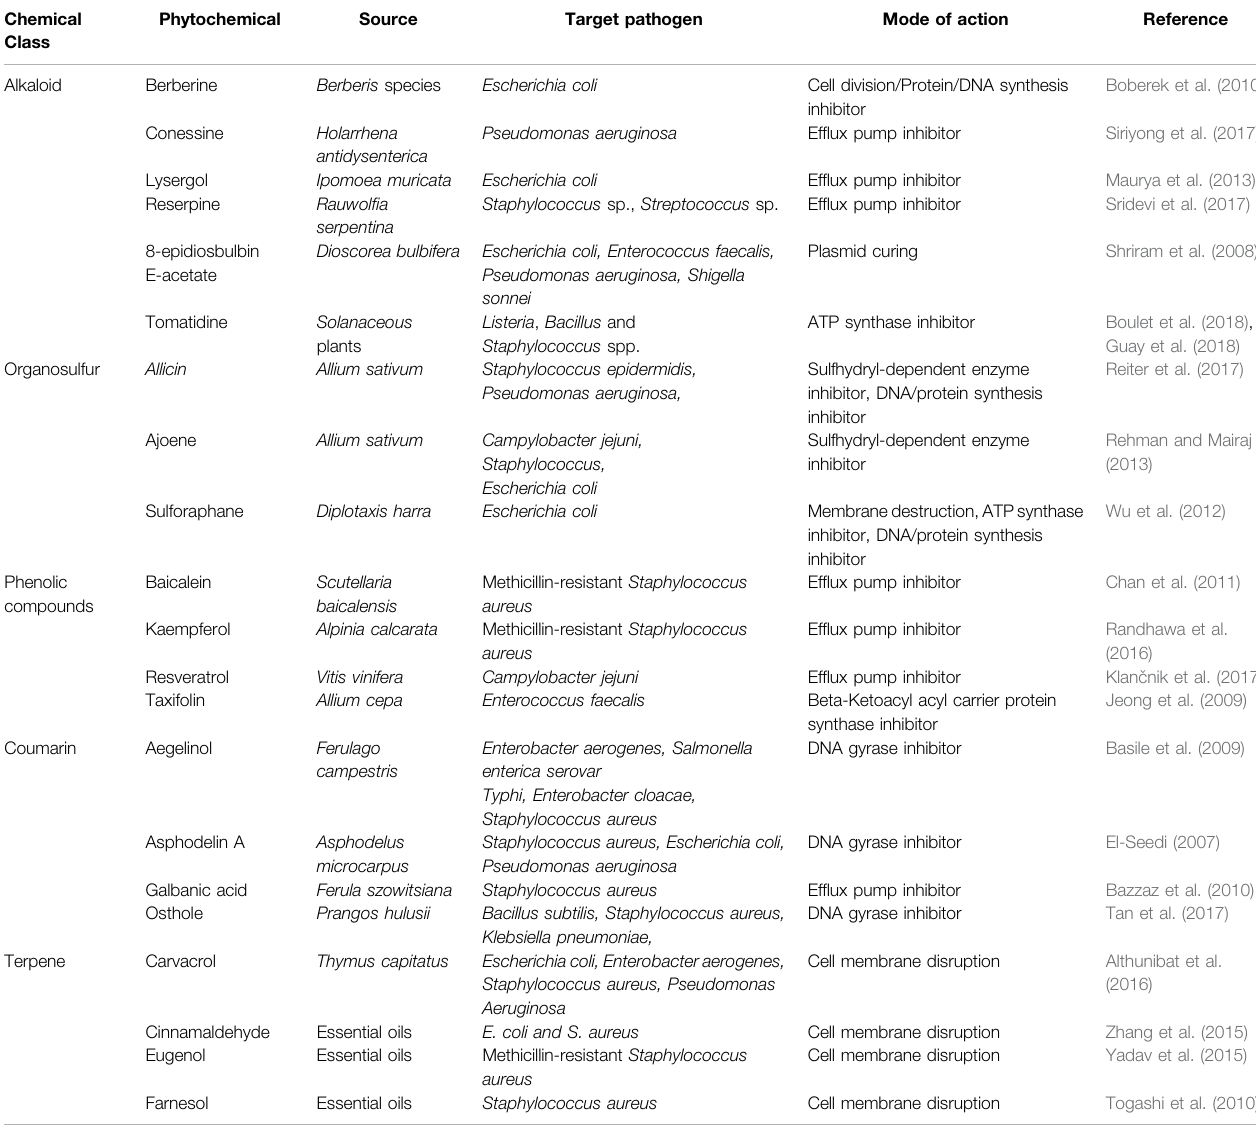
TABLE 1 | A summarized list of phytochemicals, their chemical class, source and mode of action against pathogenic strains. Chemical